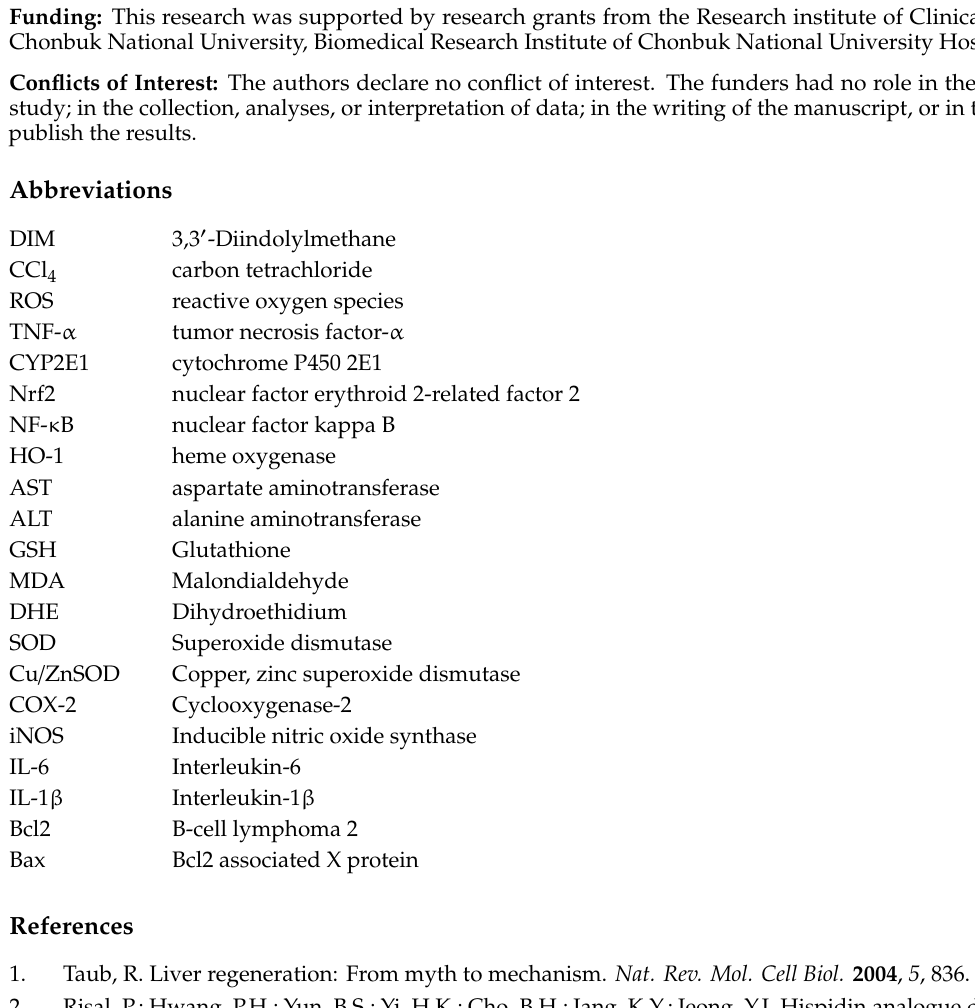
s1. Figure S1: E ff ects of DIM on histopathological changes of liver tissues, showing cellular